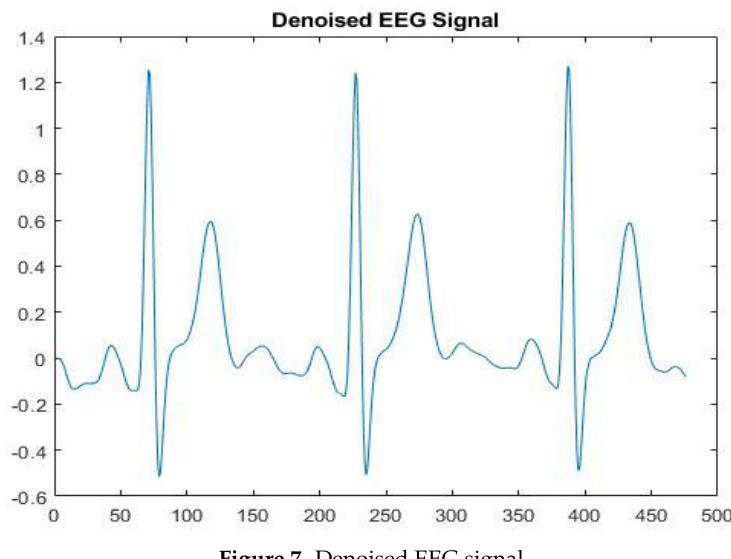
Figure 7. Denoised EEG signal.